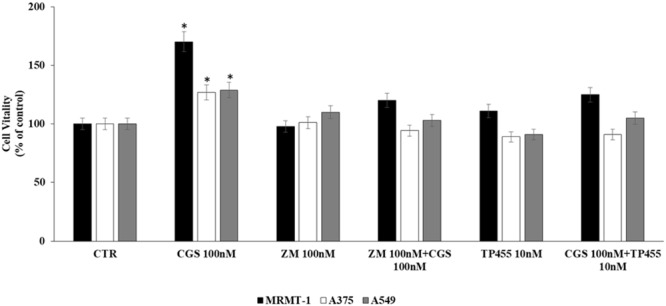
Effect of 100 nM CGS 21680 on A375 and MRMT-1 cell viability (48 h) as well as in A549 (24 h) and antagonism by 100 nM ZM 241385 and 10 nM TP455 by DELFIA Cell Proliferation Kit. Solutions were made up in DMSO and then diluted in cell culture medium (0.1 max 0.2% of DMSO). An equal amount of DMSO was used in control cells (CTR) incubated for 24 h in case of A549 and 48 h in case of A375 and MRMT-1. ∗P < 0.01 compared with CTR. Means ± SE values from four experiments are shown. Analysis was by one way ANOVA, followed by Dunnett’s test.